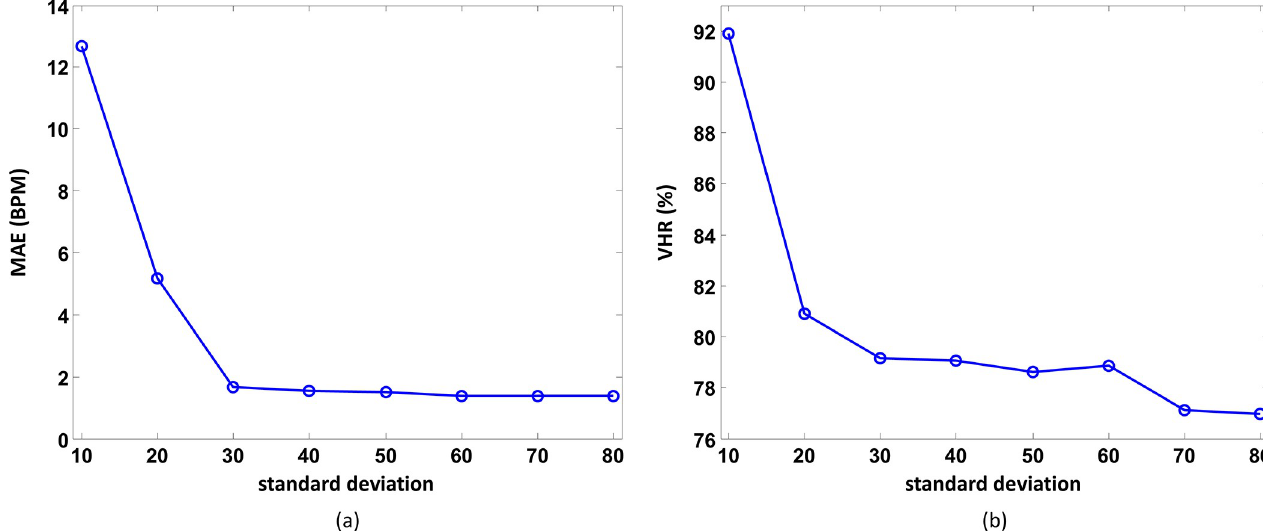
Fig 6. Variation. (a) MAE and (b) VHR with σ in the Gaussian function given by Eq (5).